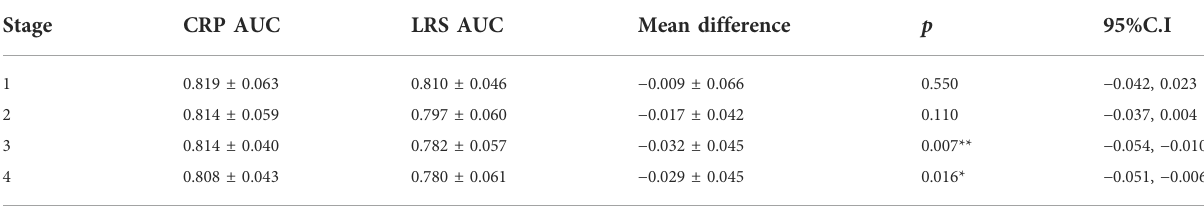
TABLE 2 Difference of knee AUC between two conditions at different running stages (Mean ± SD).